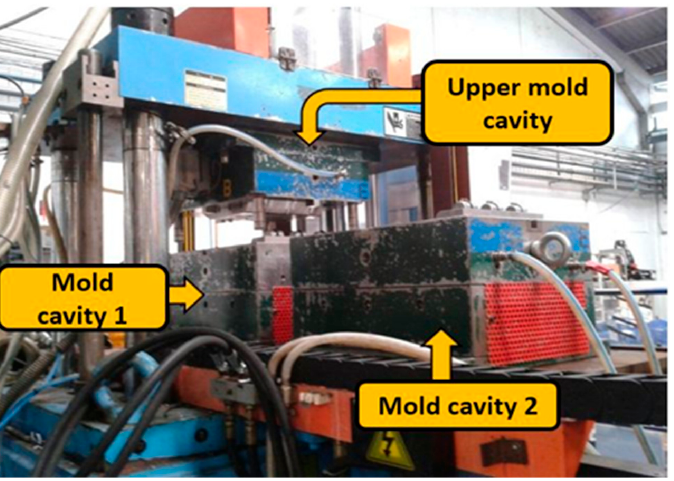
Figure 3. Vertical injection machine with sliding worktable for a mold and a half-mold. mated, however this would require action on both sides of the machine. Due to space restrictions, it is not possible to load and unload the wires from both sides of each machine with a robotic system because the amplitude of movements is too large and the space available is not enough. Moreover, to load the mold with wires it is necessary to have a proper device, which is charged with a batch of bent wires and a drawer which provides the right number of wires in the right position. Furthermore, a rotary manipulator is used to promote the movements in the X, Y, and Z axes. However, again due to lack of space, just one rotary manipulator is not enough to cover all the working area. Thus, the devices need to be replicated on both sides of the machine, where the lower molds stop after the over-injection